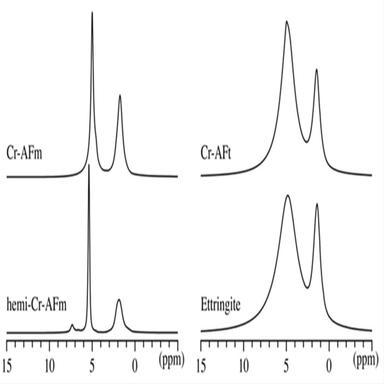
1 H MAS NMR spectra (22.3 T) for monochromate (νR = 40 kHz), hemichromate (νR = 40 kHz), chromate AFt (νR = 35 kHz), and ettringite (SO4− AFt) (νR = 40 kHz). The prominent peaks are observed at 5.01 ppm and 1.77 ppm (Cr-AFm); 5.40 ppm and 1.92 ppm (hemi-Cr-AFm); 4.86 ppm and 1.48 ppm (Cr-AFt); and 4.87 ppm and 1.43 ppm (ettringite). Image reproduced from.